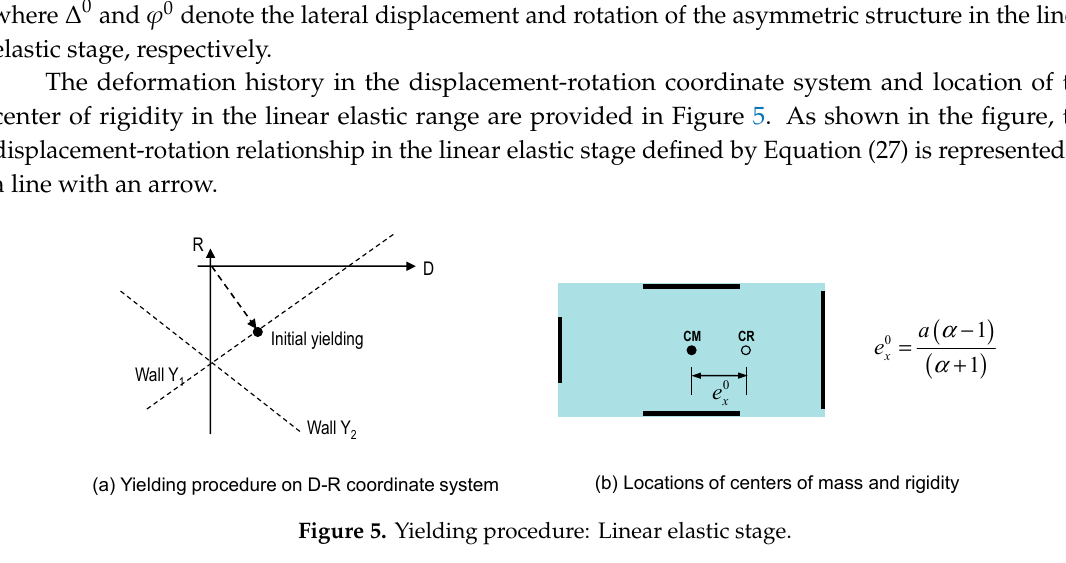
Figure 5. Yielding procedure: Linear elastic stage.